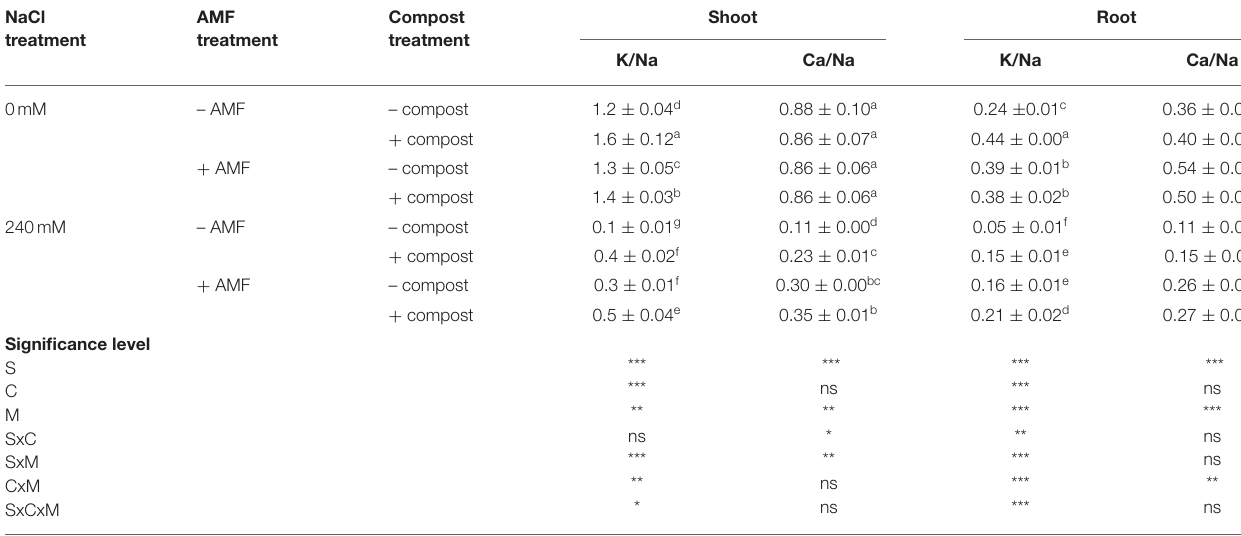
TABLE 2 | Shoot and root K/Na and Ca/Na ratios of date palm plants under saline and non-saline conditions after application of compost and AMF alone or in combination.